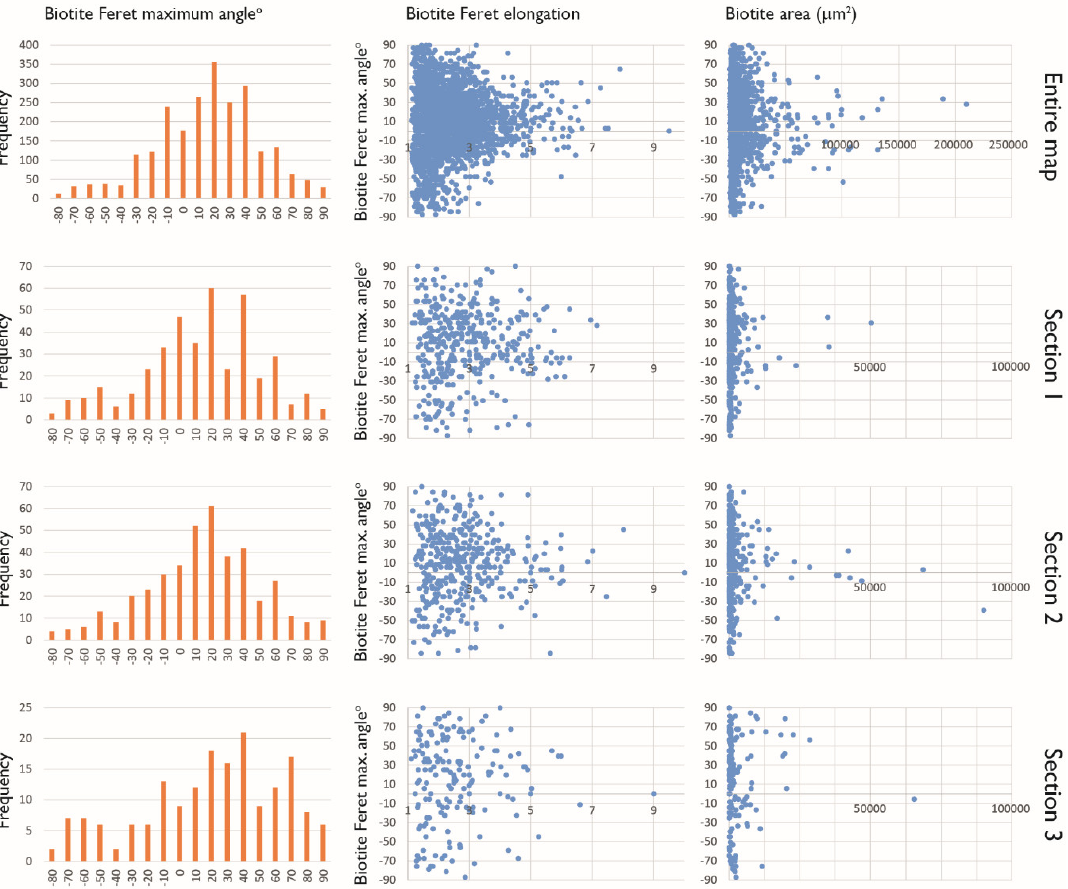
Figure 13. Plots of the maximum Feret angle frequency, and this angle compared to the elongation and area of the biotite grains and clusters of grains. Figures represent the entire map in Figure 12, as well as the three sections outlined in Figure